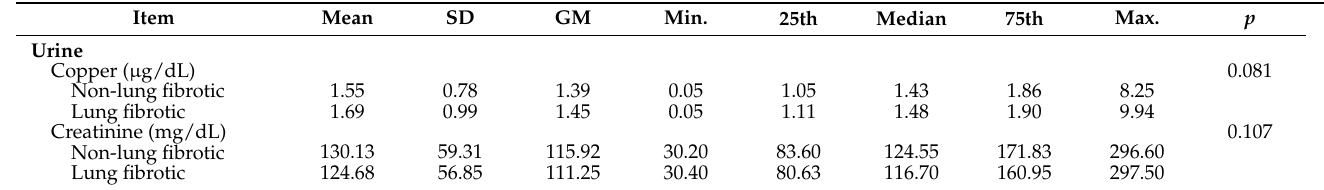
Table 2. Urinary copper and creatinine levels between individuals with lung fibrotic and non-lung fibrotic changes ( n = 1458).